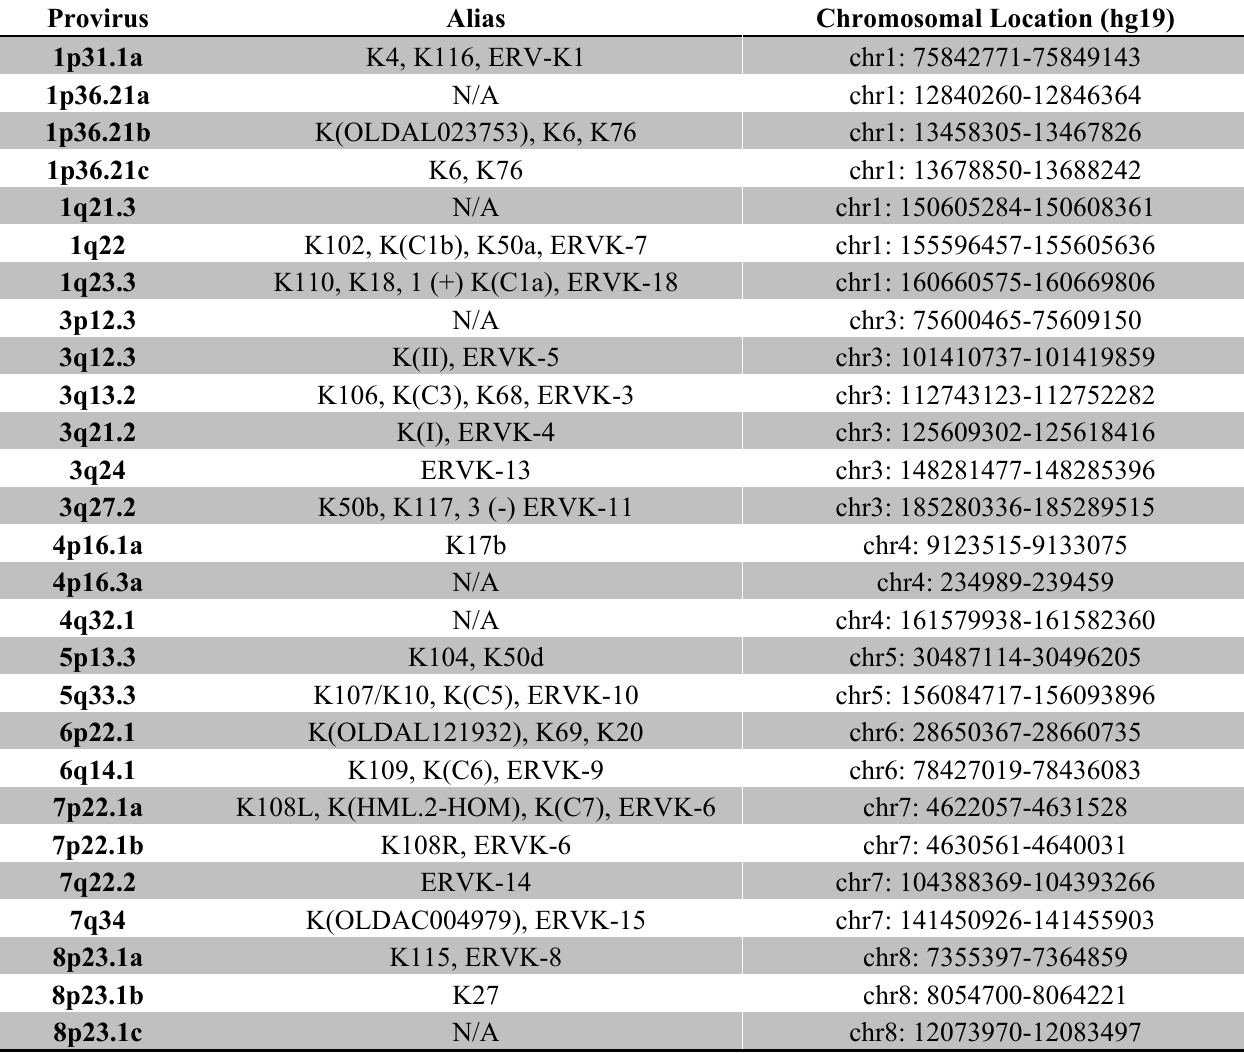
Table 1. Names and locations for discussed HML-2